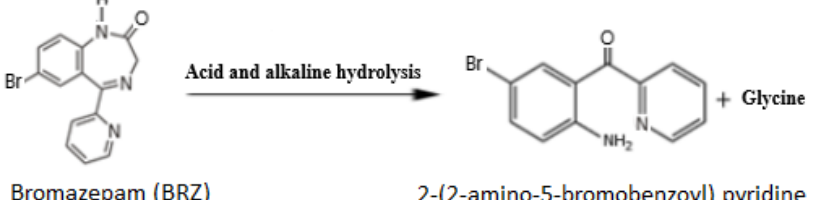
Figure 1. BRZ degradation pattern via acid and alkaline hydrolysis [36].